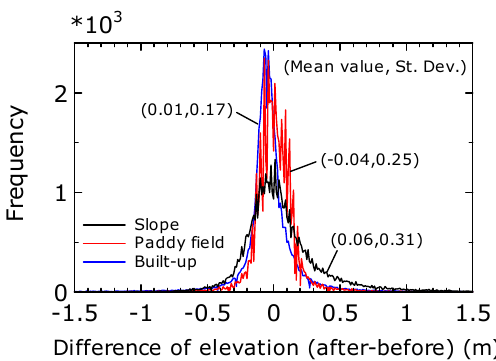
Figure 4. Histograms of difference of elevation between pre- and post-event LiDAR-derived DEMs in typical unaffected land surfaces.